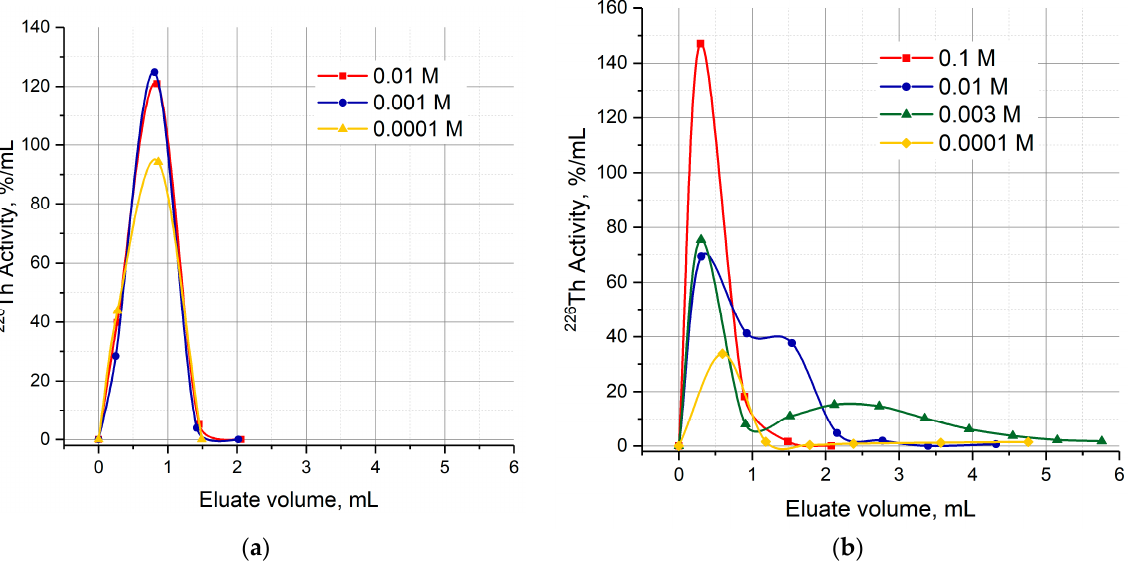
Figure 8. Curves of 226 Th elution with citric buffer solutions of different concentrations. ( a ) Elution from UTEVA resin; ( b ) elution from TRU resin.